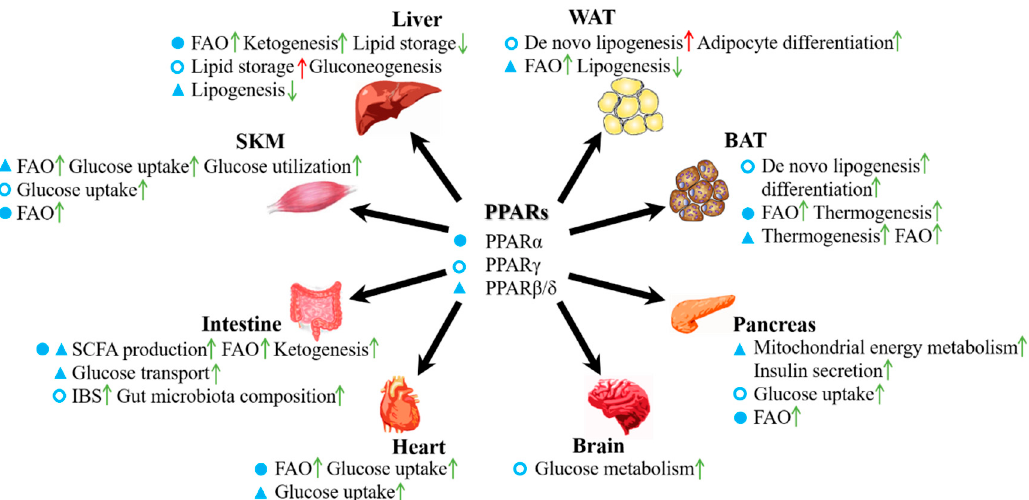
Figure 2. Roles of PPARs in the energy metabolism of various organs. The three types of PPARs are widely expressed in various organs, including the liver, WAT, BAT, pancreas, heart, intestine, and SKM. Regulation di ff erences of these PPARs in di ff erent tissues are shown and the first item in each list represents the main PPAR subtype and function for the organ. The filled circle represents PPAR α ; the empty circle represents PPAR γ ; the triangle represents PPAR β / δ ; the green arrow represents beneficial e ff ect; and the red arrow represents adverse e ff ect. For example, among the three types of PPARs, PPAR α is the master regulator in the liver and the activation of it increases FAO, induces ketogenesis, and decreases lipid storage in the liver.